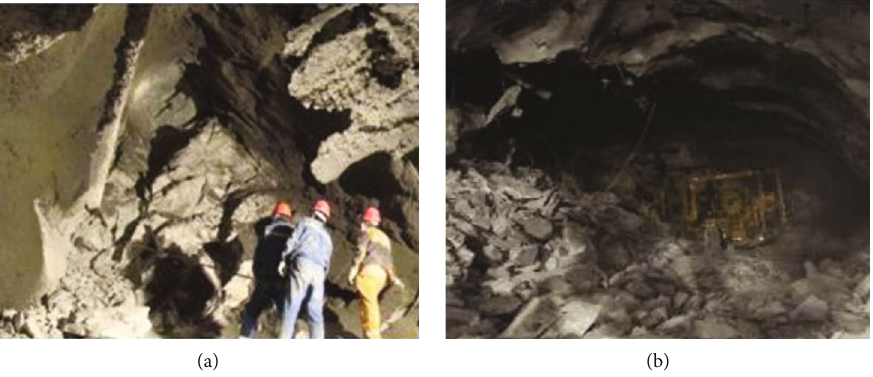
Figure 1: Excavation damage of Jinping tunnel. (a) Rock burst of Jinping tunnel on 28 November 2009 [6]. (b) Collapse of Jinping No. 4 drainage tunnel